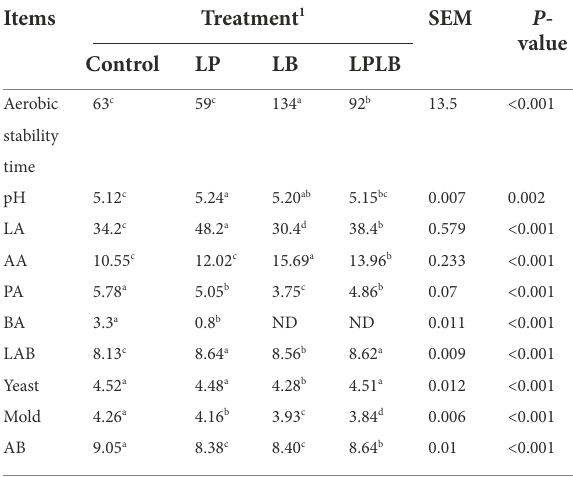
Means of three observations. Different lowercase letters indicate significant differences ( P < 0.05) between different treatments at the same time. LA, lactic acid; AA, acetic acid; LA/AA, lactic acid/acetic acid; PA, propionic acid; LAB, lactic acid bacteria; AB, aerobic bacteria. h for aerobic stability time; g/kg of DM for LA, AA, and PA. Log 10 CFU/g of fresh matter for LAB, yeast, mold, and AB. 1 Control, ensiling with no inoculant applied; LP, inoculated with L. plantarum MZ008357; LB, inoculated with L. brevis MZ008360; LPLB, inoculated with L. plantarum and L. brevis ; SEM, standard error of